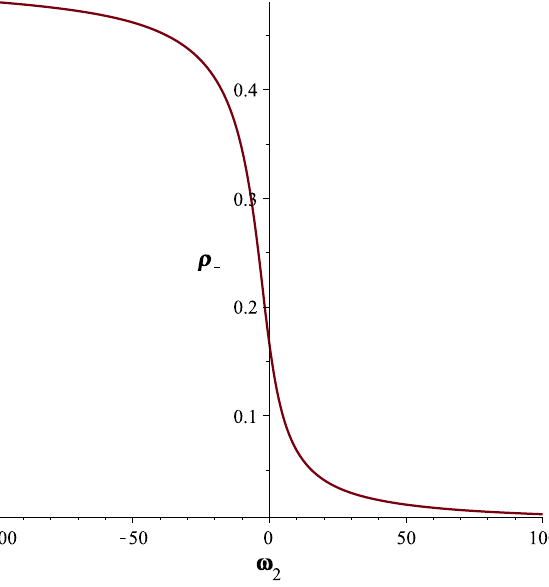
Fig. 10 The plot depicts the function ρ − (ω 2 ) as a function of ω 2 . It is clear that ρ − is in the possible range 0 ≤ ρ ≤ 1 See the tex for details